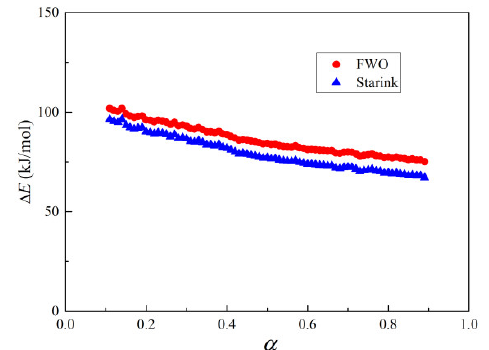
Figure 5. The extracted activation energy based on the Flynn-Wall-Ozawa (FWO) method and Starink method.